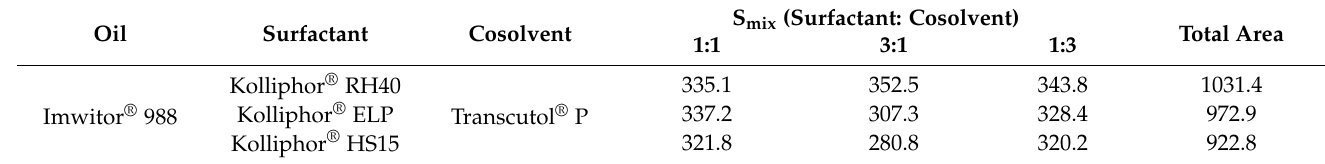
Table 3. Clear nanoemulsion areas of the pseudo ternary phase diagrams (as unit 2